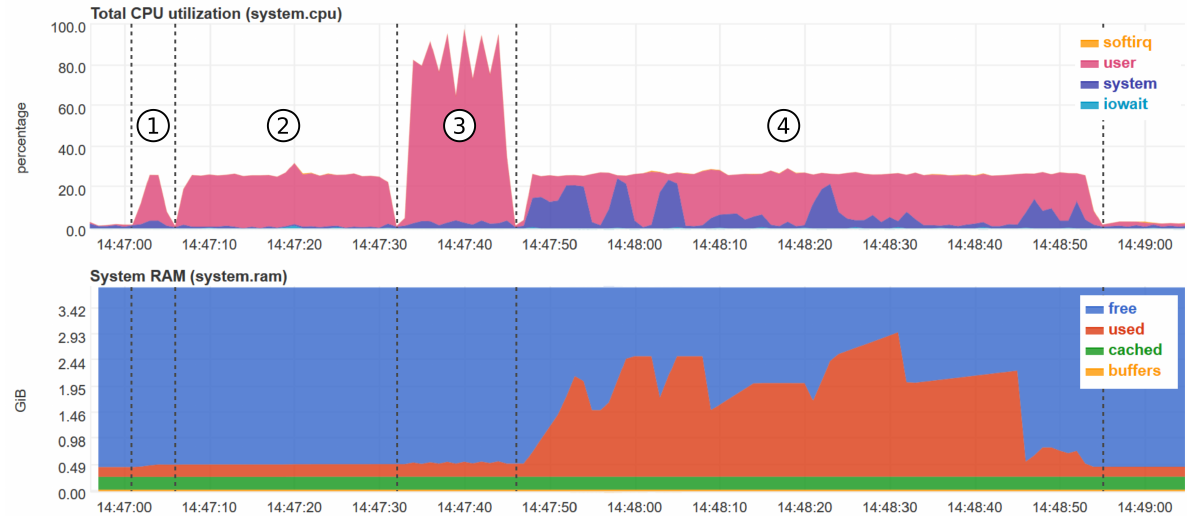
Figure 9. Snapshot of the CPU and RAM memory usage for the non-bursty case with 50% impairment rate on the RPI 4B (4GB of RAM) for each algorithm (1-mean imputation, 2-MICE imputation, 3-missForest imputation, 4-kNN